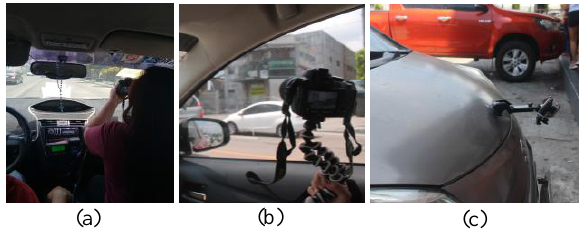
Figure 3: Video acquisition: (a, b) DSLR Camera held inside the car; and (c) GoPro camera mounted at hood of car